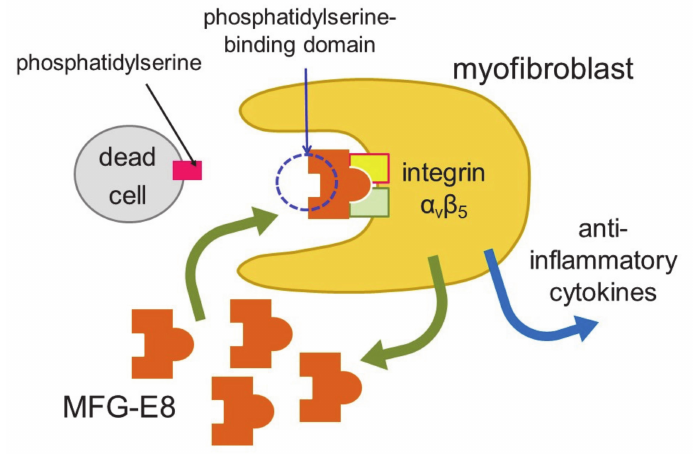
Figure 2. Engulfment of dead cells by myofibroblasts. Myofibroblasts engulf dead cells with the help of MFG-E8 secreted by themselves and then secrete anti-inflammatory